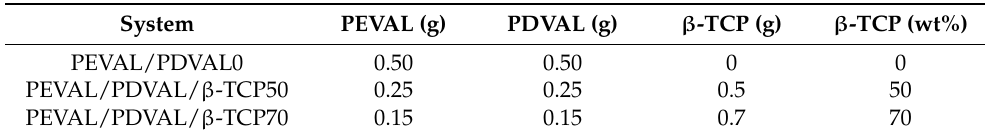
Table 1. Preparation conditions of the poly( δ -valerolactone)/poly(ethylene-co-vinylalcohol)/ β - tricalcium phosphate (PEVAL/PDVAL/ β -TCP)